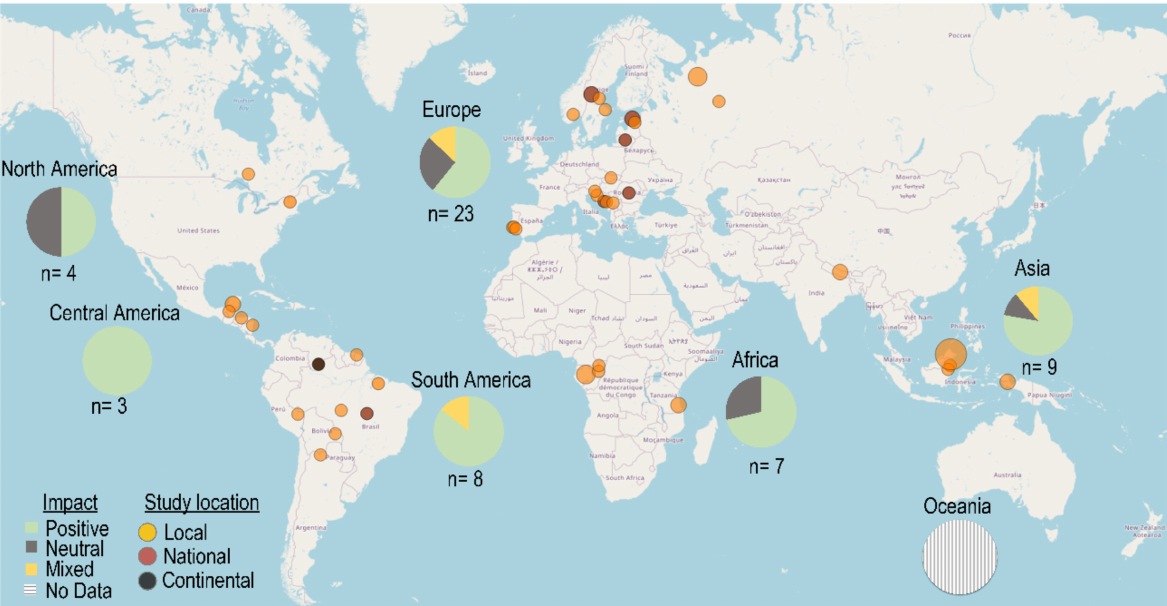
Figure 7. Global distribution of case studies on the impact of forest certification on forest degradation. The size of the dots represents the relative number of case studies per location. Study locations: Local studies are here equal or smaller than districts/states. National studies indicate that multiple case studies across the country were investigated. Pie charts show the number of case studies and the reported impact per region. Base map: ©